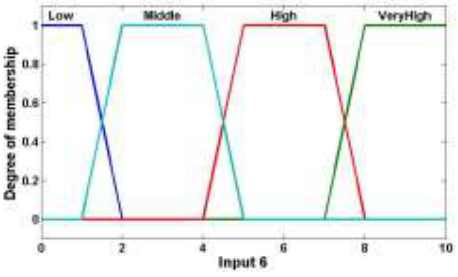
Figure 7. Membership functions of the Input 6